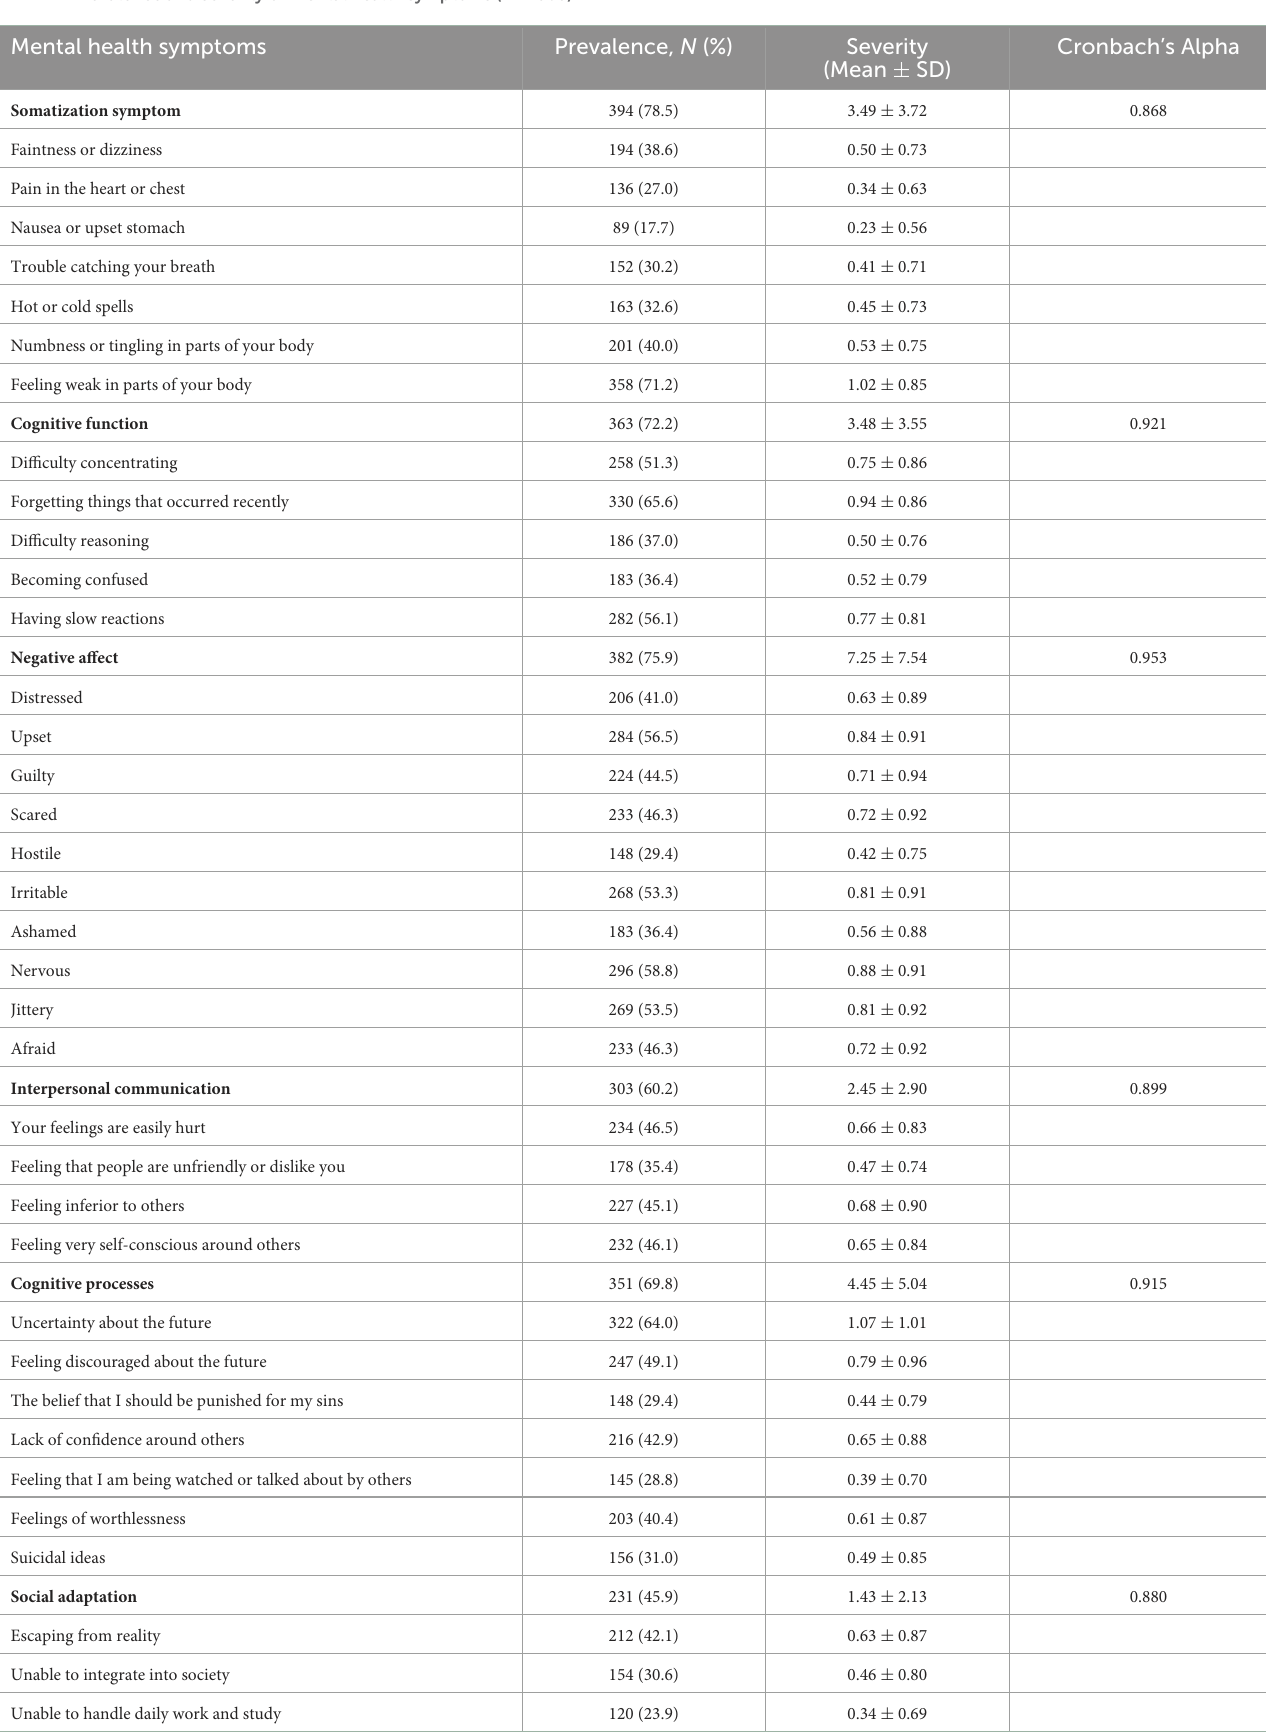
TABLE 2 Prevalence and severity of mental health symptoms ( N = 503). Mental health